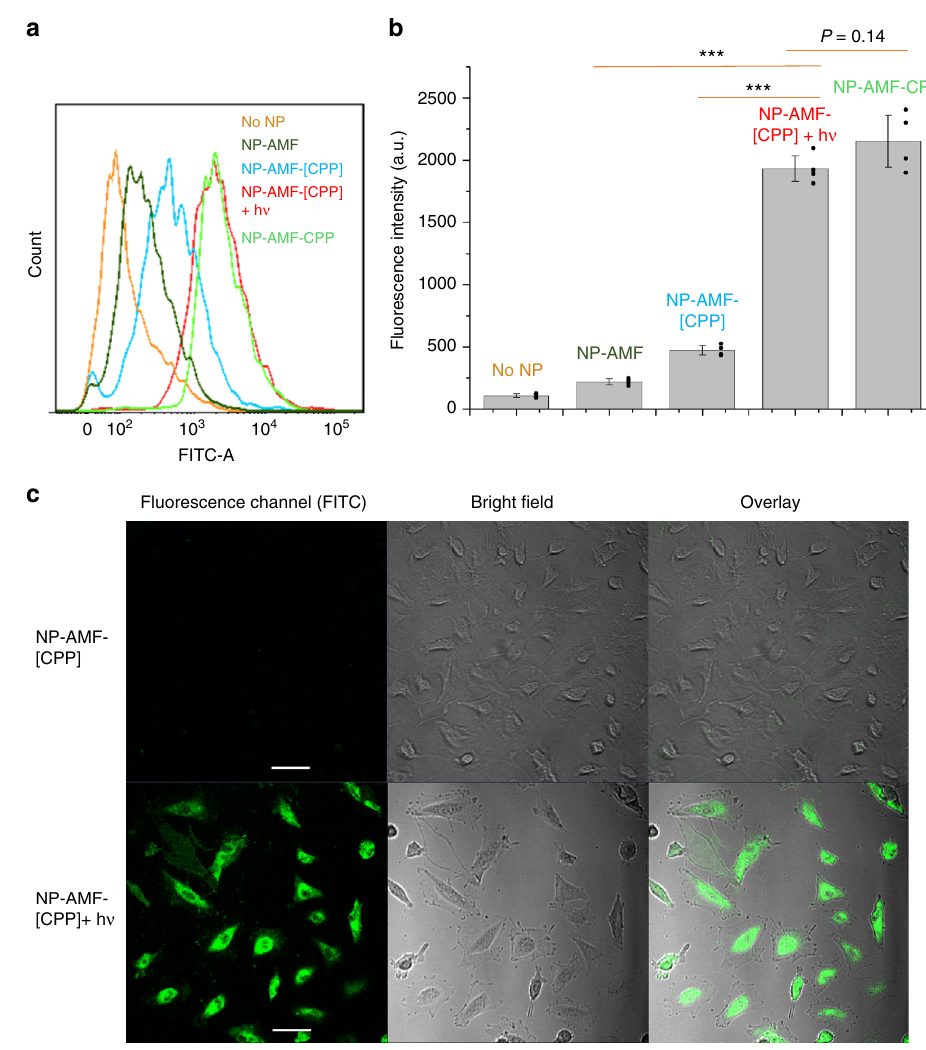
Fig. 2 Light-triggered cell uptake of nanoparticles. a Representative fl ow cytometry of FITC fl uorescence within HUVEC cells treated with different nanoparticles or without nanoparticle. b Quantitation (mean of four median values of fl uorescence intensity) of fl ow cytometric analyses (such as the one in panel A) of HUVEC uptake of nanoparticles. Data are means ± SD ( n = 4 independent experiments). *** P < 0.001 (unpaired t -test). c Representative confocal microscopic images of HUVEC uptake of nanoparticles. The scale bar is 20 μ